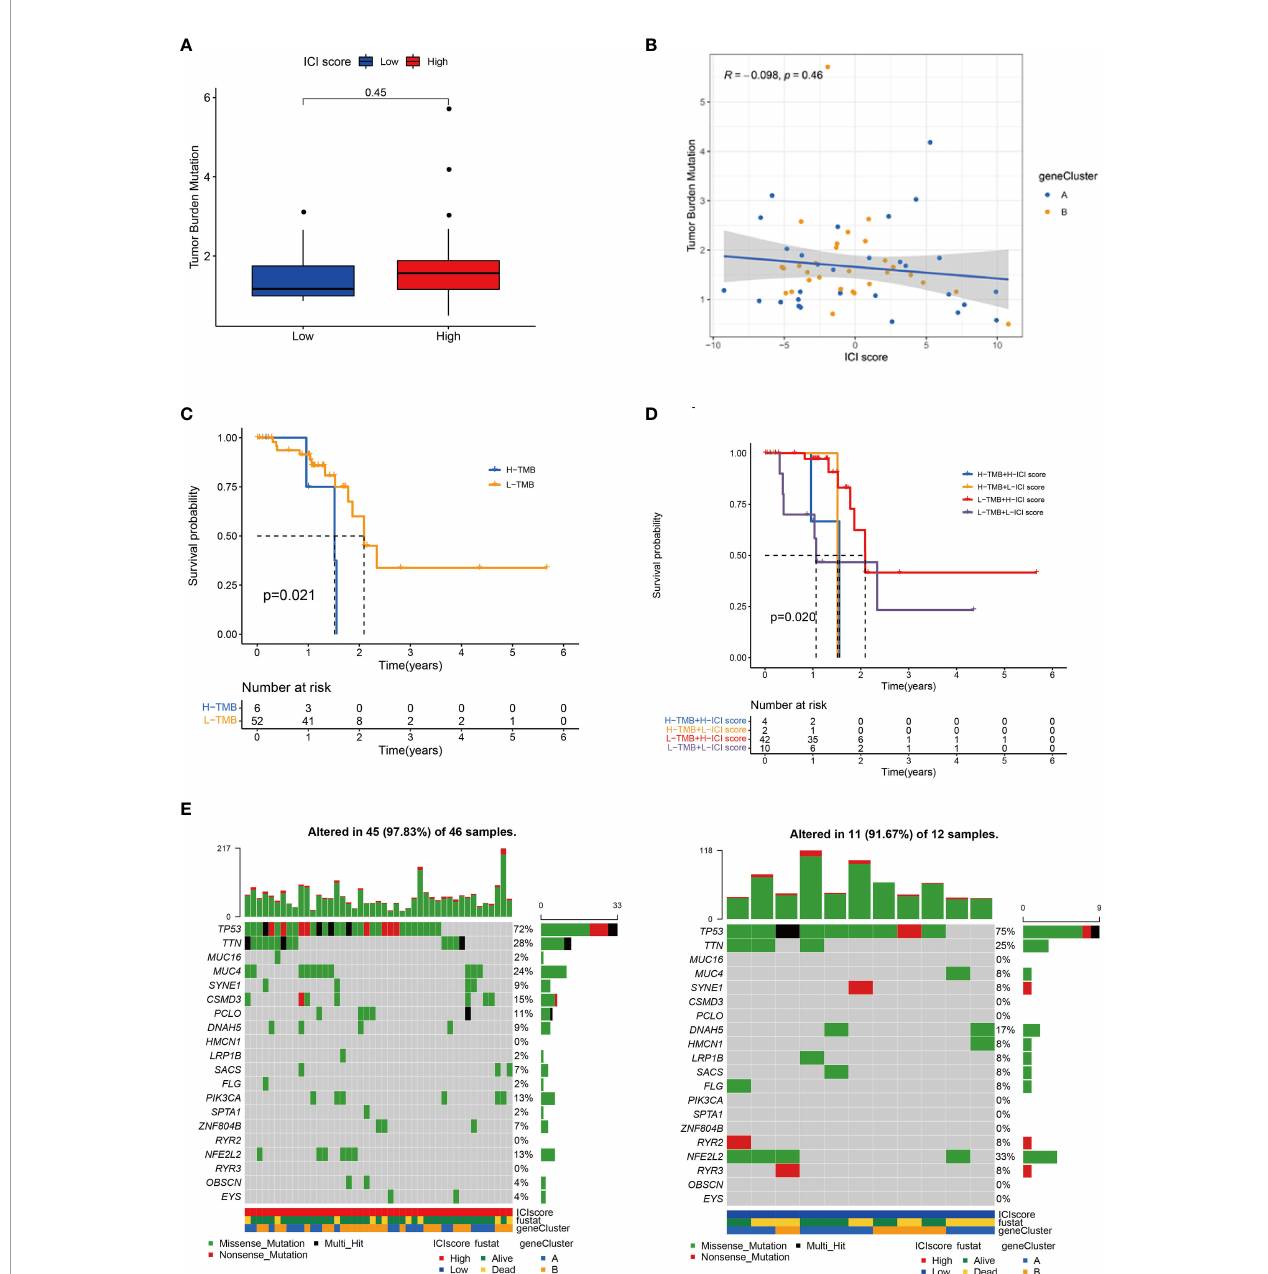
FIGURE 4 | Correlation between ICI score and TMB. (A) TMB difference between high and low ICI score groups. (B) Scatter plots of the Spearman correlation between ICI score and TMB. (C) Kaplan – Meier curves for high and low TMB groups. Log rank test P = 0.021. (D) Kaplan – Meier curves for patients strati fi ed by TMB and ICI score. Log rank test P = 0.020. (E) OncoPrint of high (left) and low (right) ICI score groups. Each column represents a single patient. The bar chart at the top represents TMB. The bar chart on the right shows the mutation frequency of each gene in the group with high or low ICI